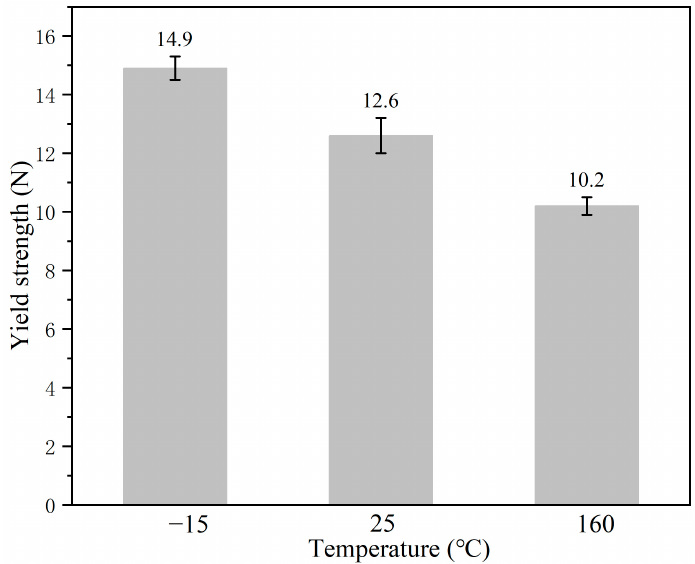
Figure 8. Compressive strength of the Ca alginate capsules.